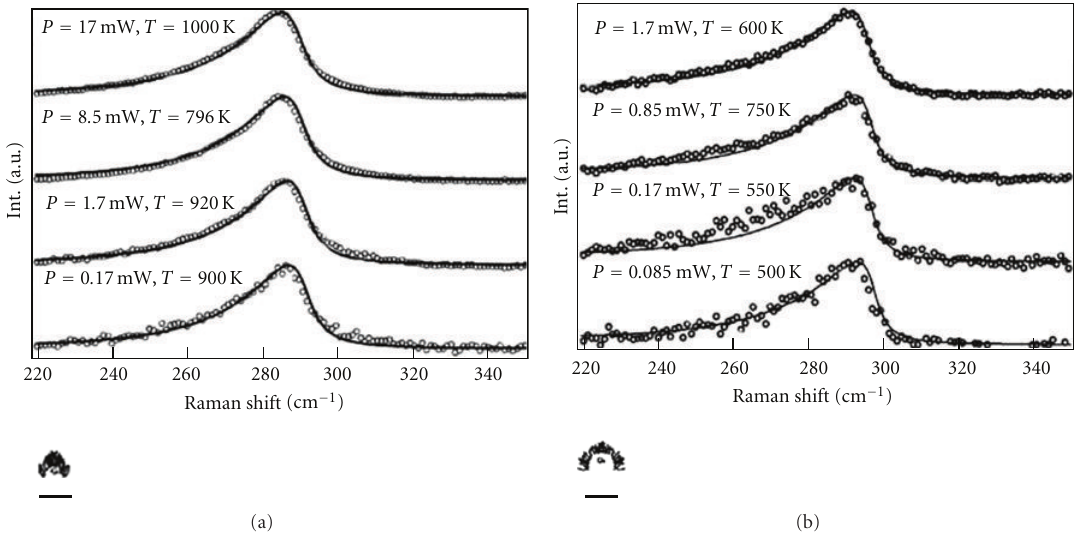
Figure 11: Raman spectra at 632.8 nm for the Ge nanowire ( D = 7nm) for varying laser power levels (circles) at two di ff erent Ga droplet sizes (a) droplet size ∼ 1 μ m and (b) droplet size ∼ 1 mm. The solid lines represent the least square fit (10)